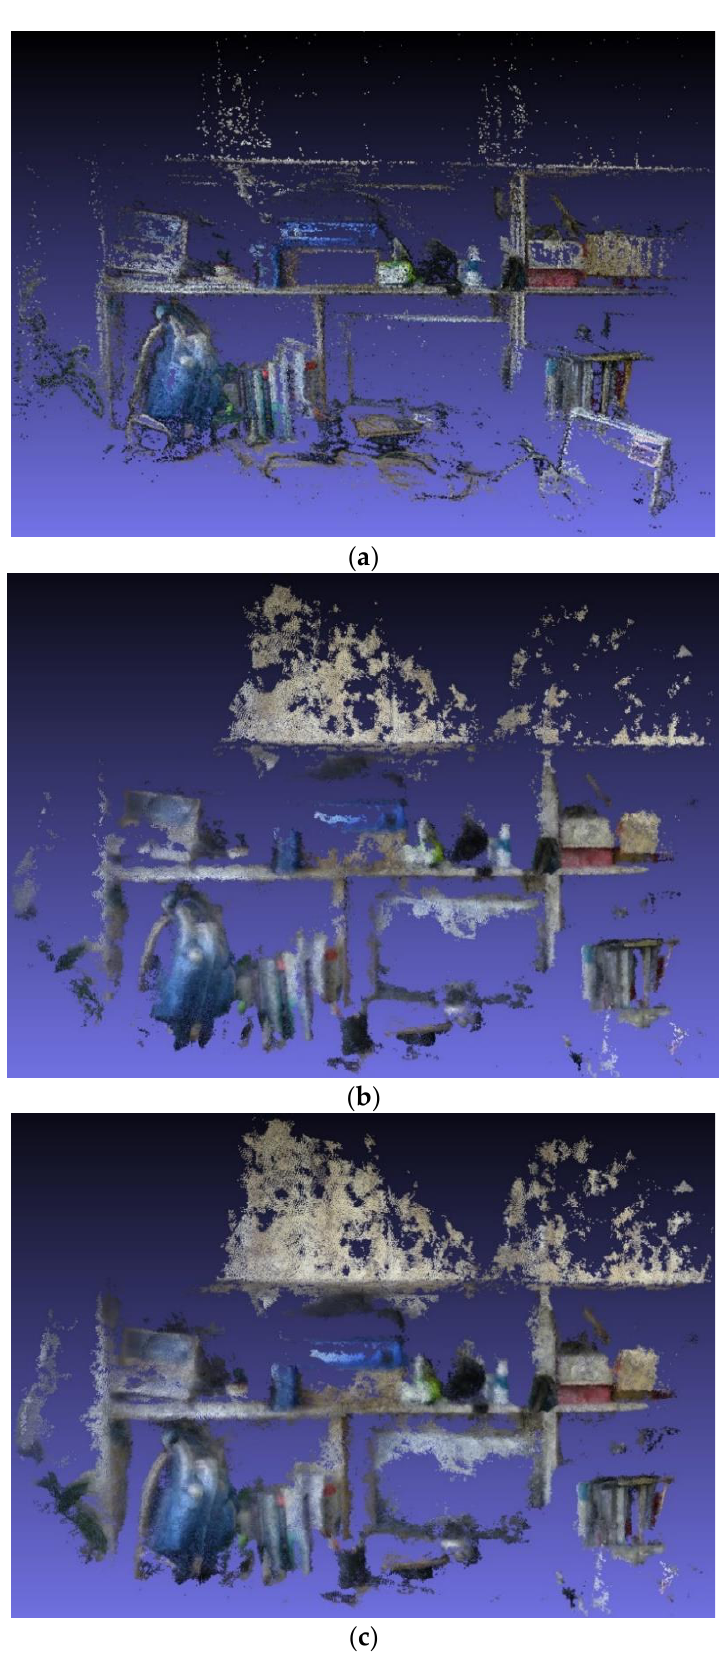
Figure 22. Overall 3D reconstruction results of the different methods. ( a ) Traditional method; ( b ) MVSNet; ( c ) CES-MVSNet.